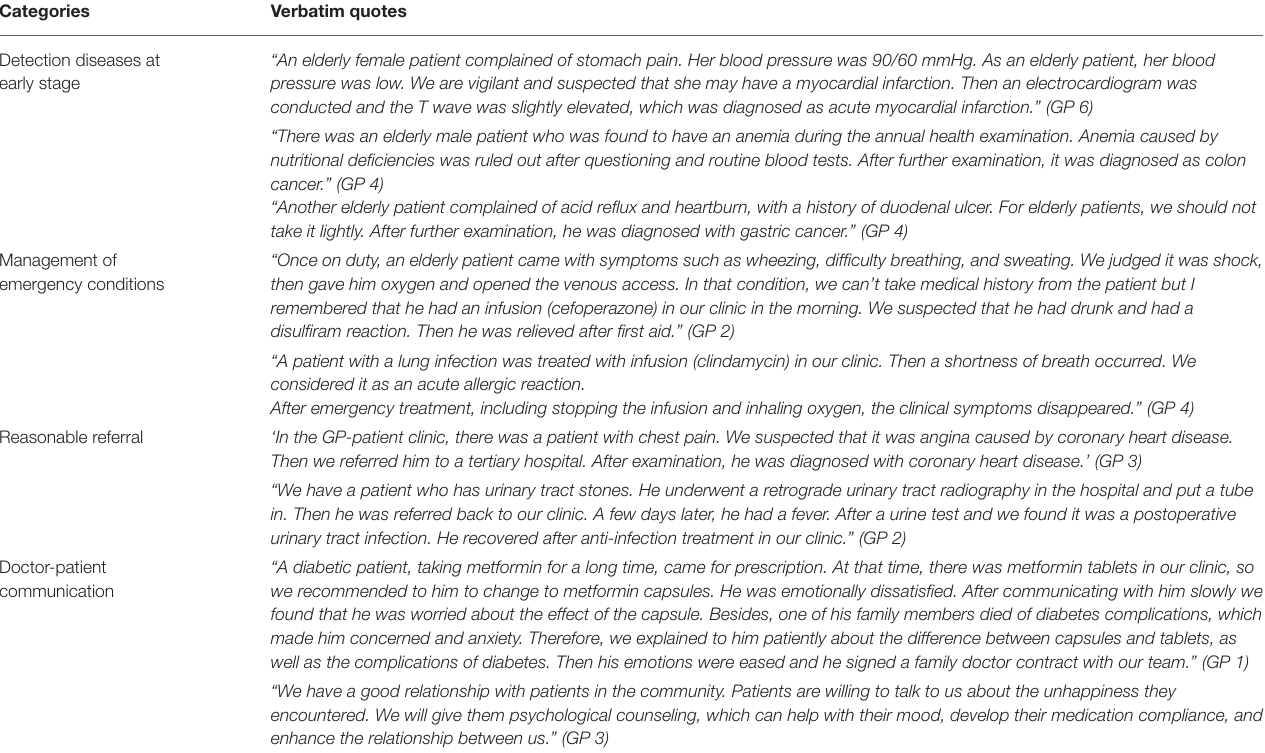
TABLE 4 | Categories and subcategories from content analysis of critical incidents. Categories Verbatim quotes Detection diseases at early